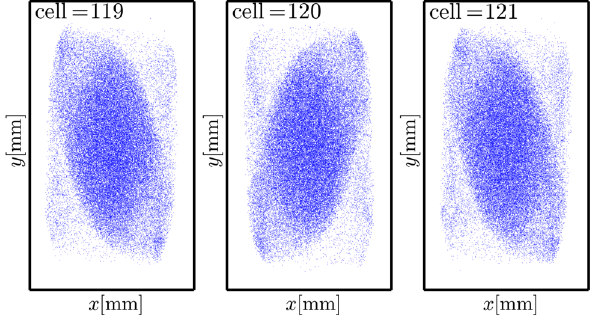
FIG. 7. Real space distribution for three representative con- secutive cells at early stage of skew mode sum instability with initial η x ¼ 0 . 67 .